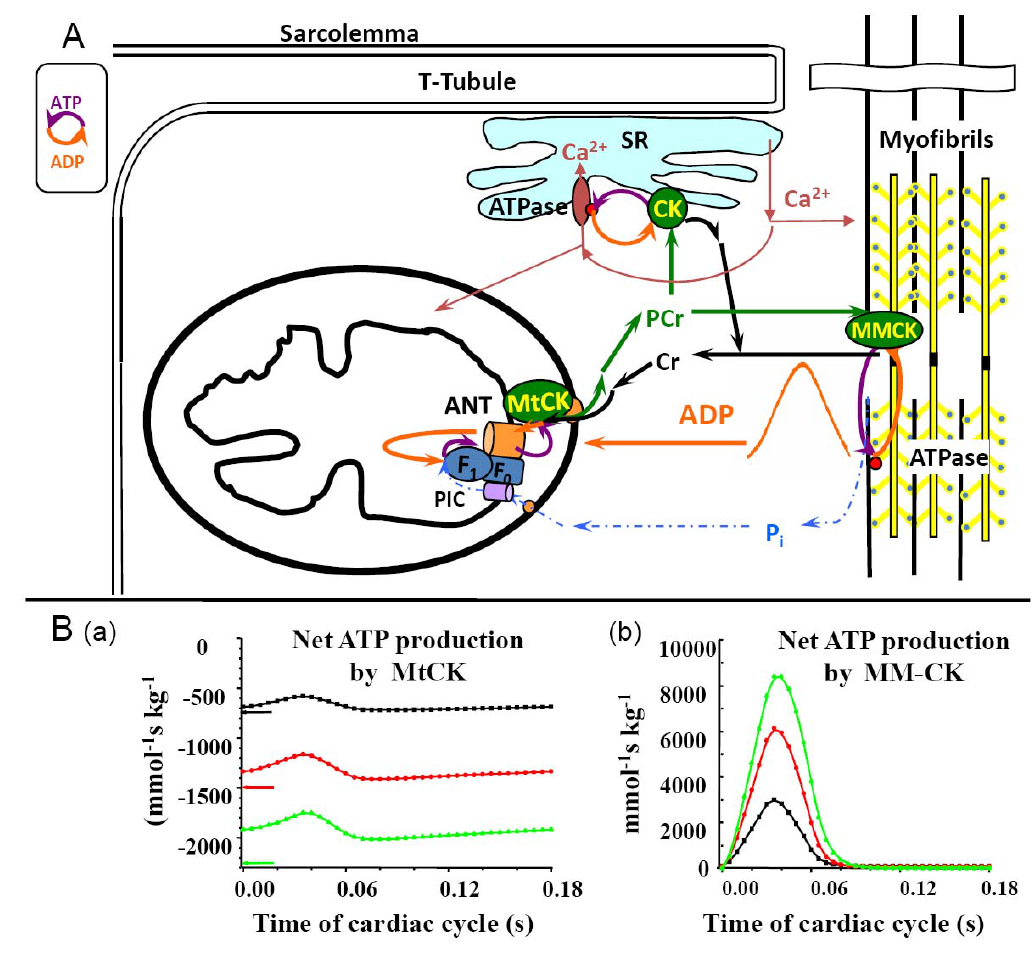
Figure 7. Separation of energy transfer by PCr flux and information transfer by low amplitude metabolites’ concentrations in cardiomyocytes: realization of cybernetics principle of feedback regulation. (A) Scheme represents intracellular energy unit (ICEU) consisting of ATP production sites (mitochondrion, glycolysis), ATP consumption sites (myosin ATPase, SERCA, ions-pumping-ATPase) communicating via the system of compartmentalized creatine kinase (CK) isoforms and PCr/CK phosphotransfer network. (B) Non-equilibrium state of MtCK in mitochondria and MM-creatine kinase reactions at sites of ATP utilization functioning in mitochondria opposite directions. (a) In mitochondria the constant rate of net PCr production in non- equilibrium steady state of coupled MtCK reaction is established for any workload to meet the cellular energy requirements [colored lines correspond to different workloads depicted in Figures 5B and 7B(b)]. (b) The cyclic changes in rates of ATP regeneration in non-equilibrium myofibrillar MMCK reaction during contraction cycles at different workloads correspond to oscillations of [ADP]c described in Figure 5B (colored lines in both figures show the amplitudes of ADP and ATP productions to different heart workloads, Figure 5B). Reproduced from [158–160] with